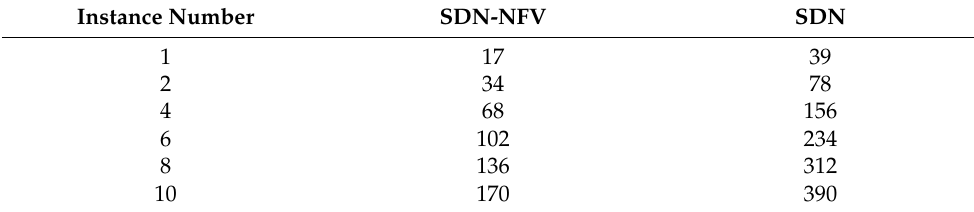
Table 12. Comparison of measurement times for adding integrated policies.